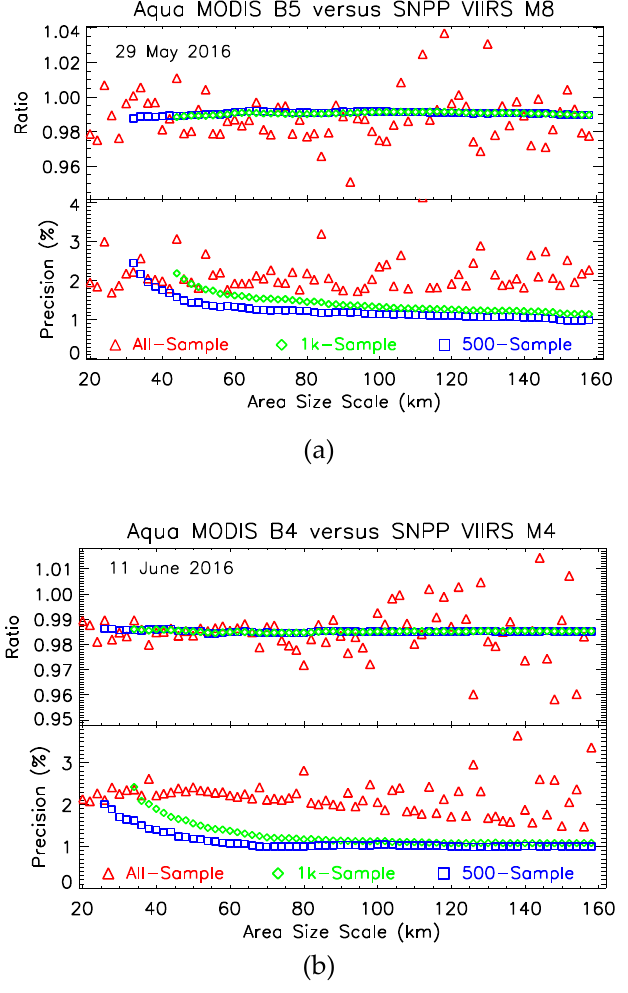
Figure 6. The scale-dependent result of radiometric comparison of ( a ) Aqua MODIS B5 versus SNPP VIIRS M8 on 29 May 2016 and ( b ) Aqua MODIS B4 versus SNPP VIIR M4 on 11 June 2016, for ratio (top panel) and the error bar (bottom panel) versus area size for the three cases of unconstrained sample size (red stars), constrained size at 1000 samples (blue squares), and constrained size at 500 samples (green diamonds).